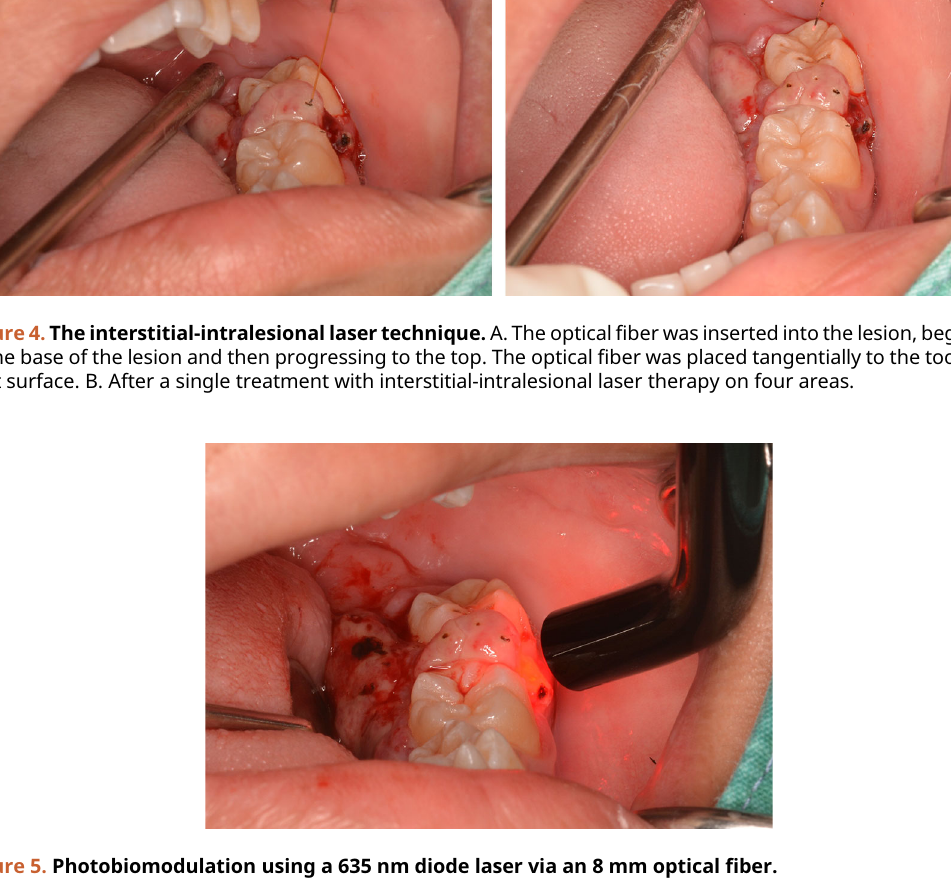
Figure 5. Photobiomodulation using a 635 nm diode laser via an 8 mm optical fiber.